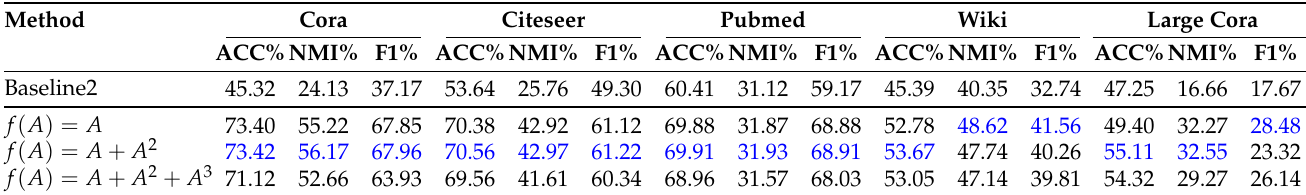
Table 5. Results of the ablation study. GLGC is tested with different f ( A ) .